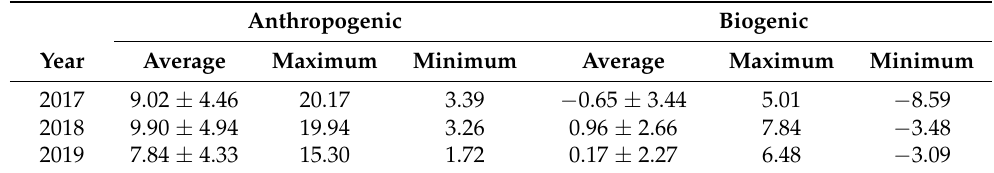
Figure 3. Wintertime biogenic and anthropogenic CO 2 . The CO 2 mixing ratios in this plot were estimated using the respective wintertime β − 1 values and Equation (5). Table 2. Wintertime biogenic and anthropogenic CO 2 (ppm) mixing ratios calculated using the CO tracer technique. The number of days ( n ) in winter 2017, 2018, and 2019 are 33, 25, and 19, respec- tively.